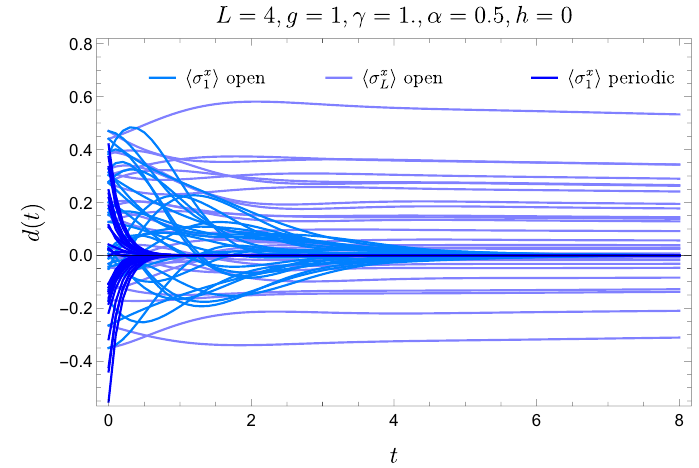
〉 and 〈 σ x 〉 for the topological L 1